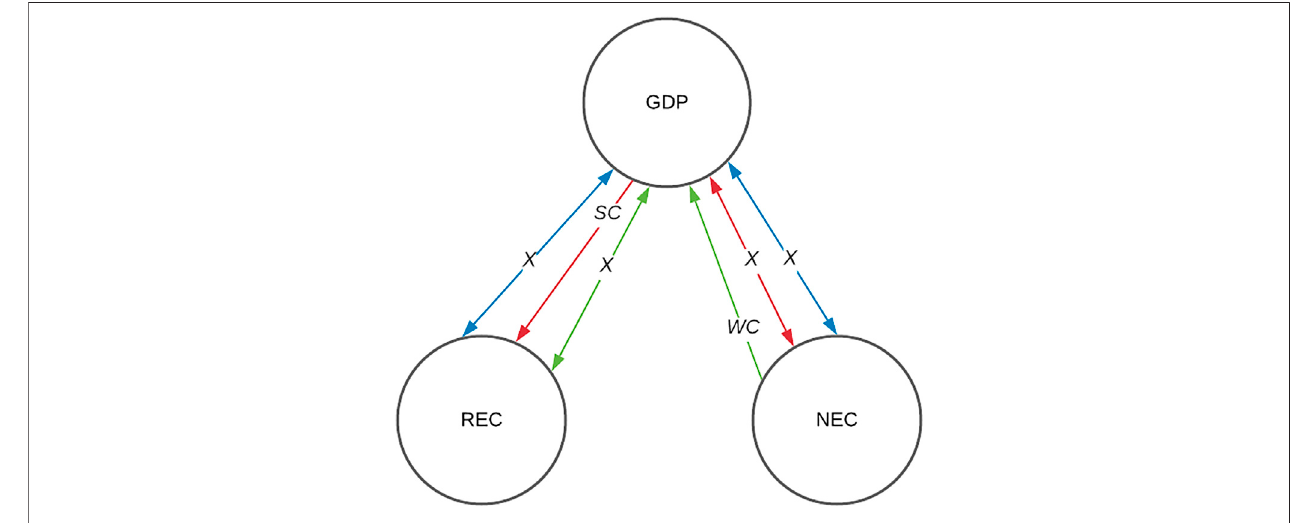
with Spanish insights. SC , WC and X refer to Strong Causality, Weak Causality, and no causality, respectively. For each country, the comparative nexus analysis has been conducted on a multivariate framework comprising also labour force, Gross Fixed Capital Formation and exports of goods and services. However, given the explicit aim of the paper, only the linkages operating among economic growth, renewable energy consumption and nuclear energy use are displayed